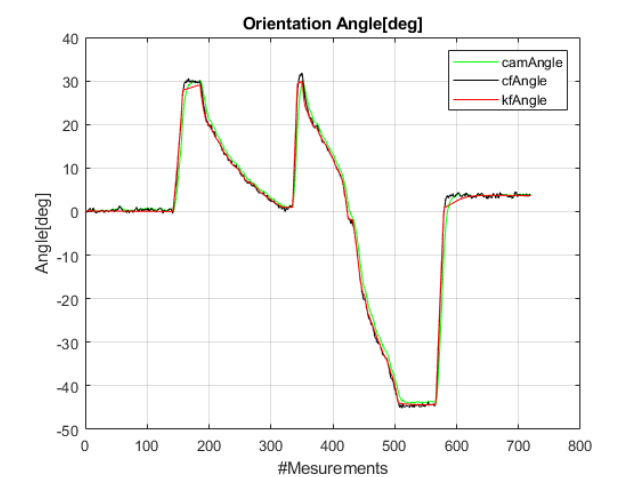
Figure 20. Rapid turning test: Orientation angle of the Mantis v2 ( θ m ) estimated using accelerometer and gyro fusion in the complementary filter (CF), Kalman filter (KF), and vision system.